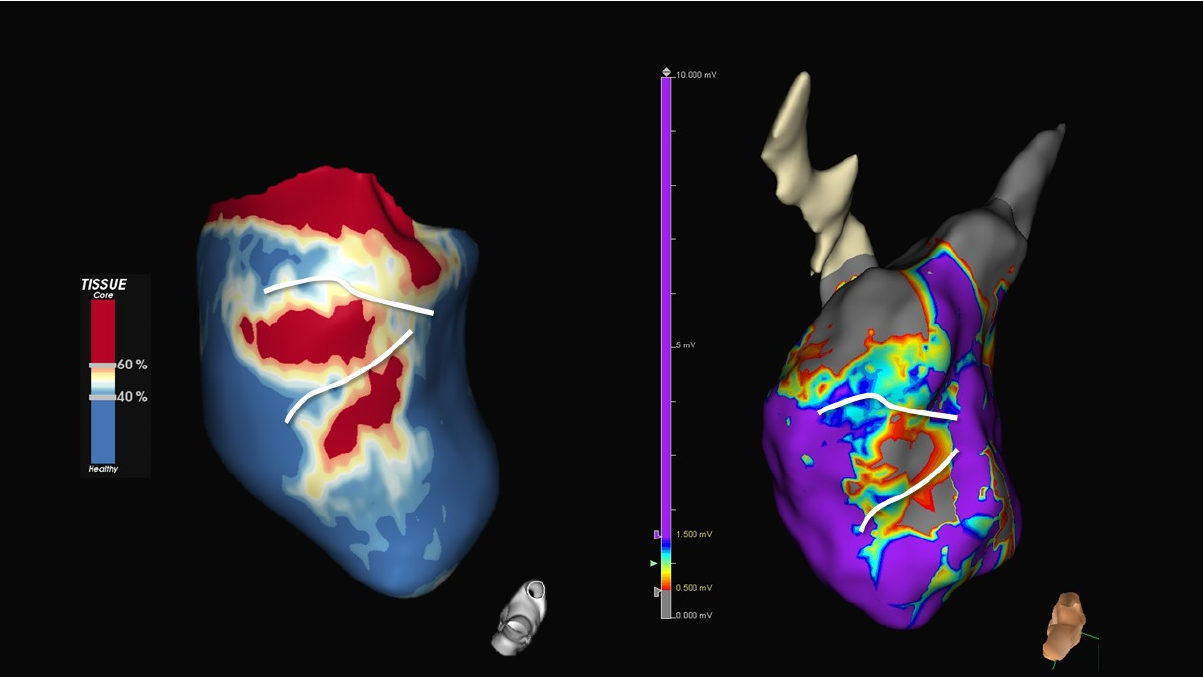
Figure 4. Example of correlation of the 3D-VI reconstruction from LGE-MRI with electroanatomical voltage map. From left to right: LGE-MRI map (colour-coding: blue: healthy tissue, yellow: border zone and red: core scar) with two clear conducting channels (white line); and electroanatomical map high density voltage map showing septal scar (colour-coding: purple: healthy tissue, red: border zone and grey: core scar), with conducting channels at the same region as compared to the LGE-MRI.